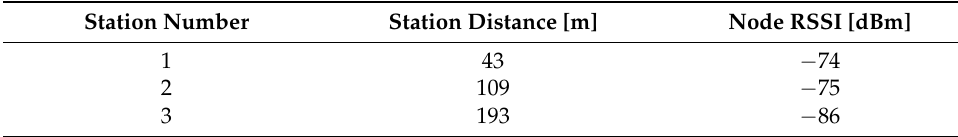
Table 6. Communication test results—Urban